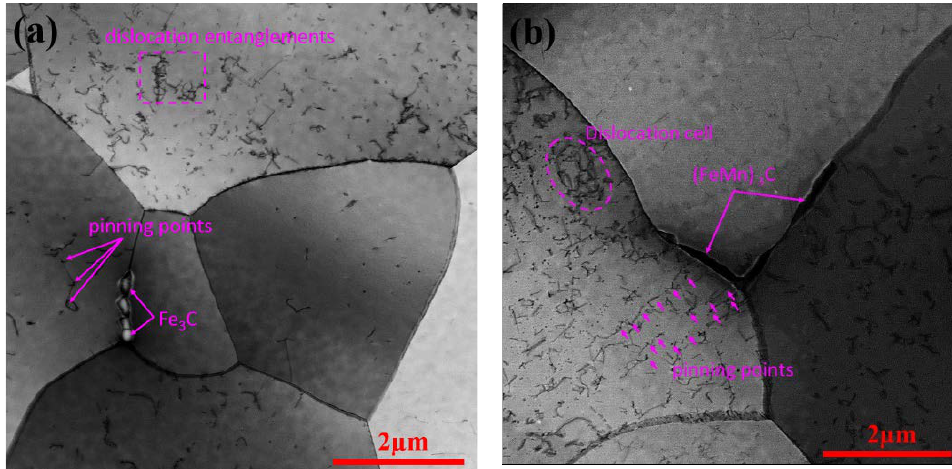
Figure 14. Dislocation structure of different C content: ( a ) ELC; ( b ) LC.